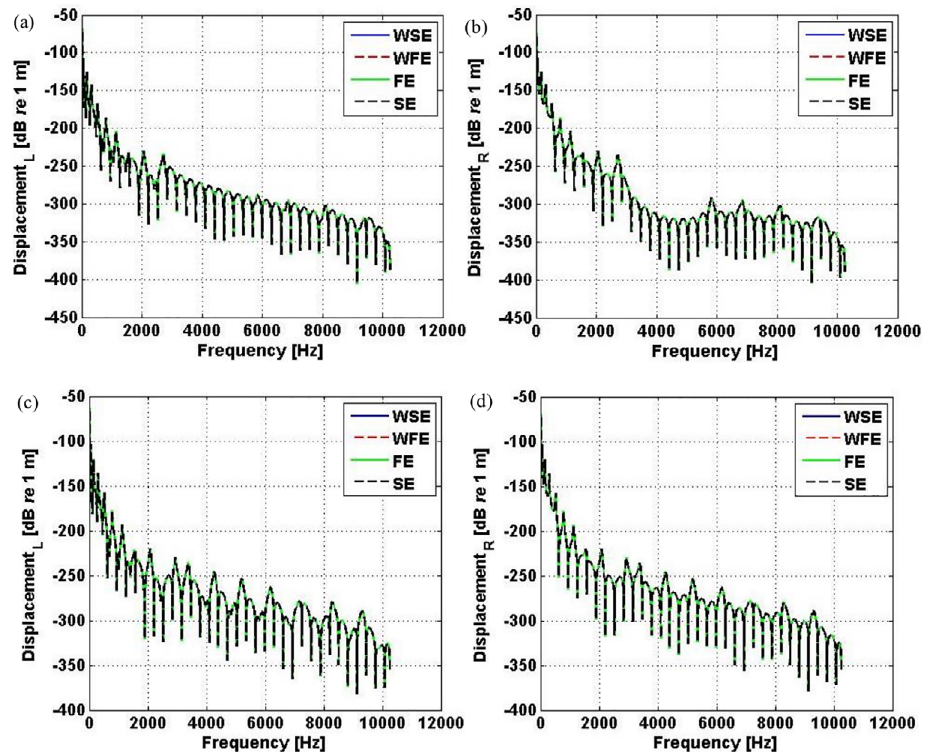
Figure 2. PC beam displacement of the left (a-c) side, first node, and right (b-d) side, last node, calculated by WSE, WFE, FE and SE methods, considering models 1 (a-b) and 2 (c-d).